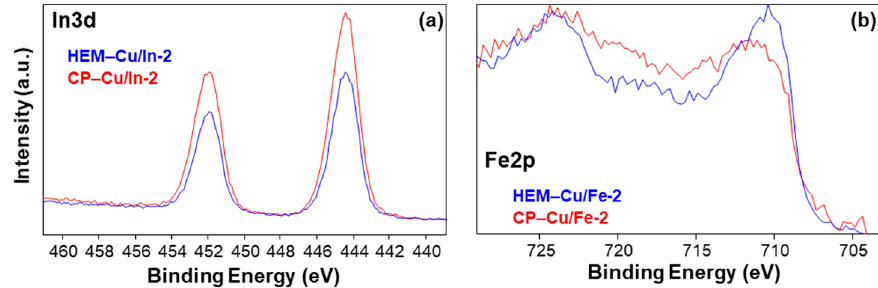
Figure 2. XP spectra for ( a ) In 3d and ( b ) Fe 2p core levels in mixed metal oxides samples.